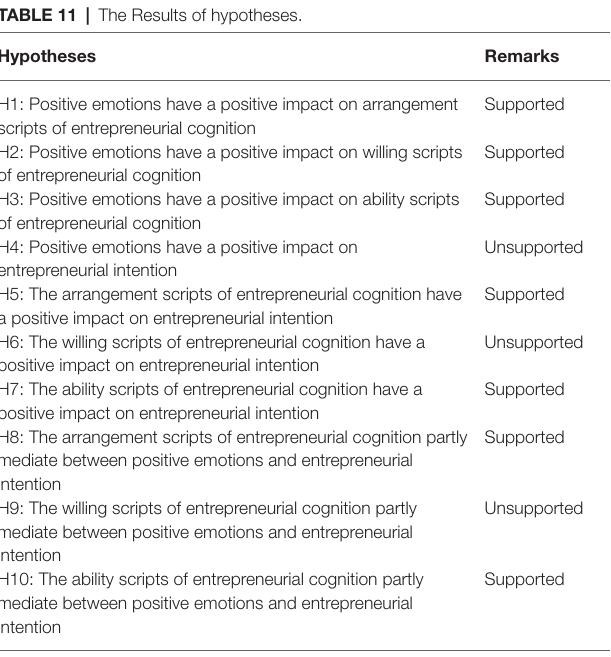
TABLE 11 | The Results of hypotheses.